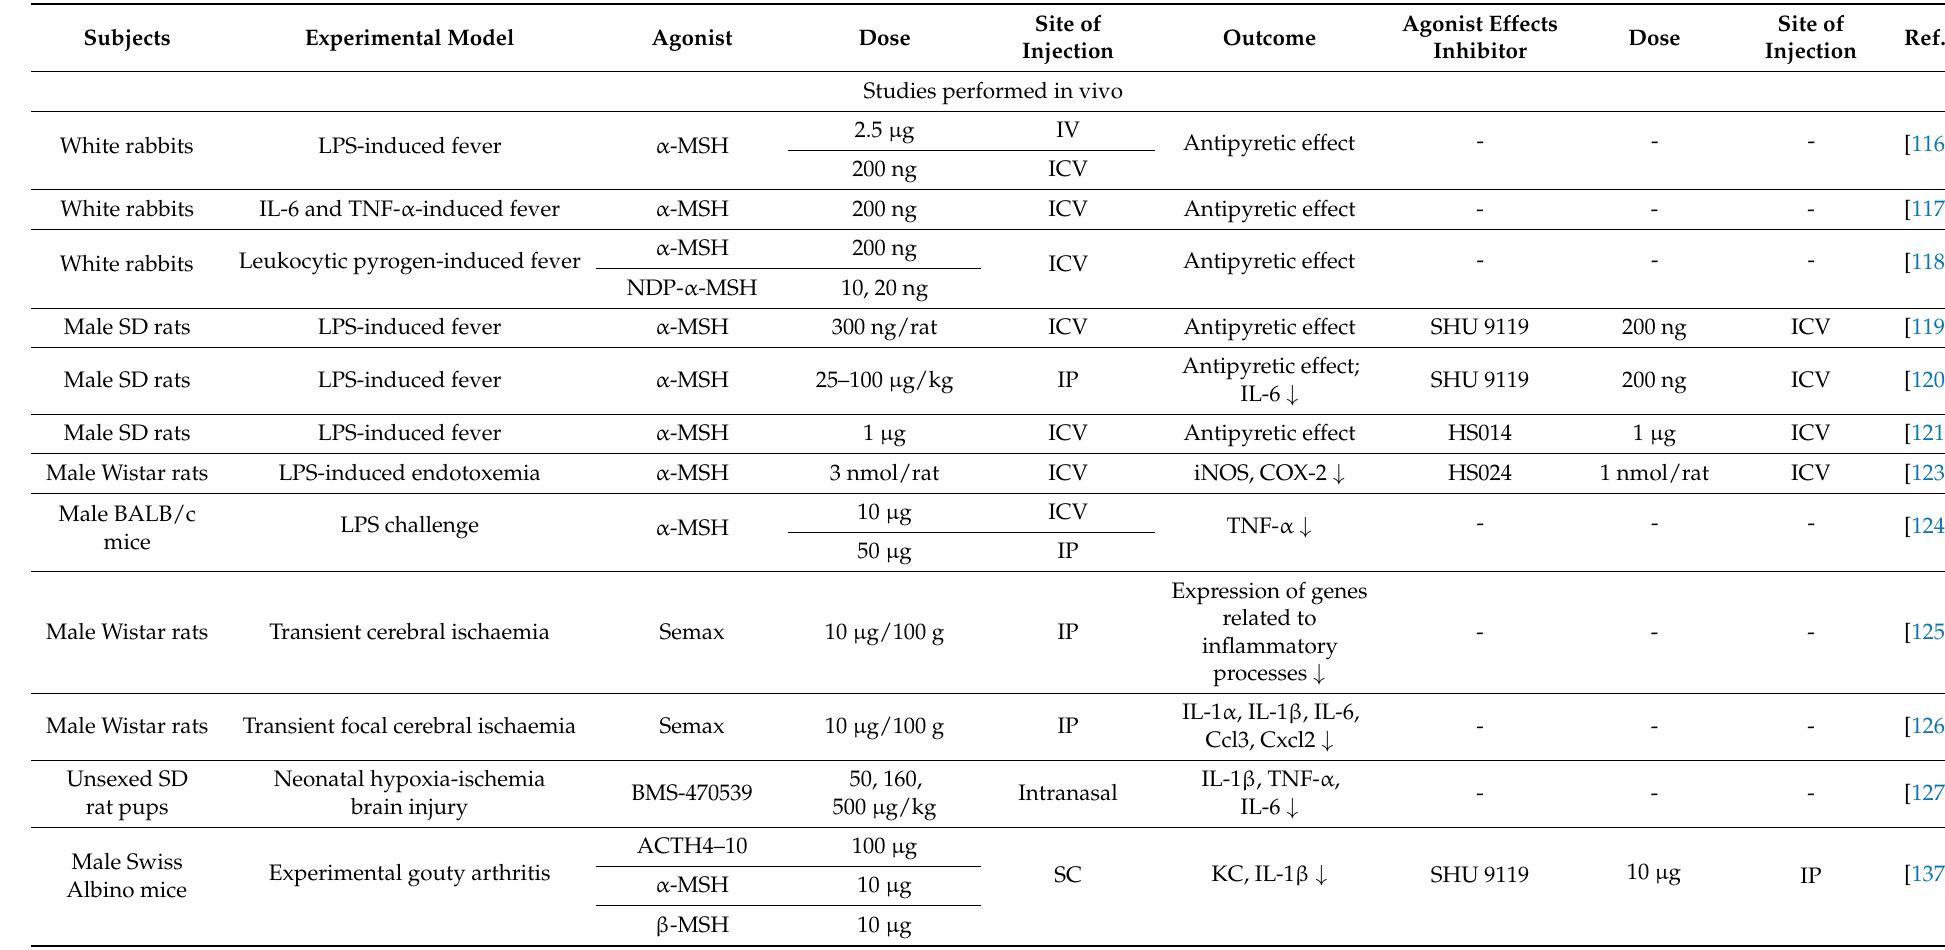
Table 3. A summary of the effects of endogenous and synthetic melanocortin agonists in different models of